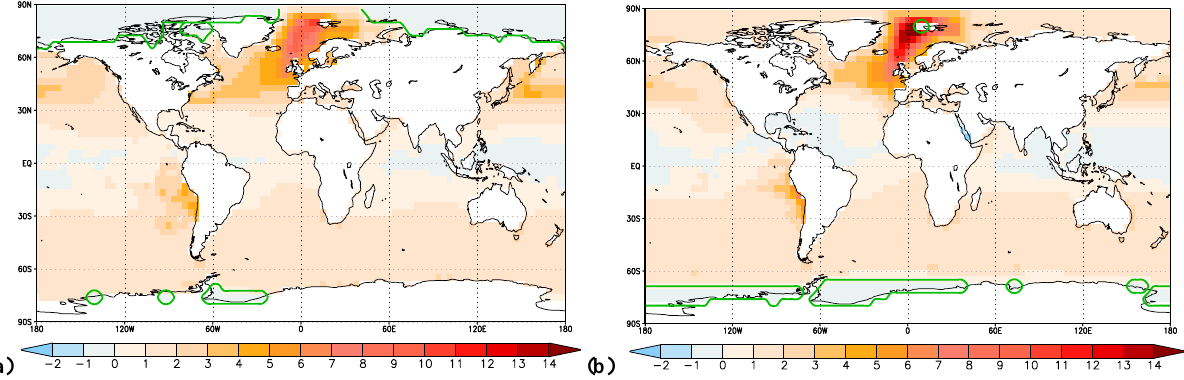
Fig. 3. Anomaly between the climatological SST forcings of the mid-Pliocene and PI control simulations of experiment 1 in units of ◦ C. The green contours indicate the 90% isoline of the absolute sea ice cover prescribed for the mid-Pliocene simulation. Shown are the forcings for the months January (a) and August (b) .